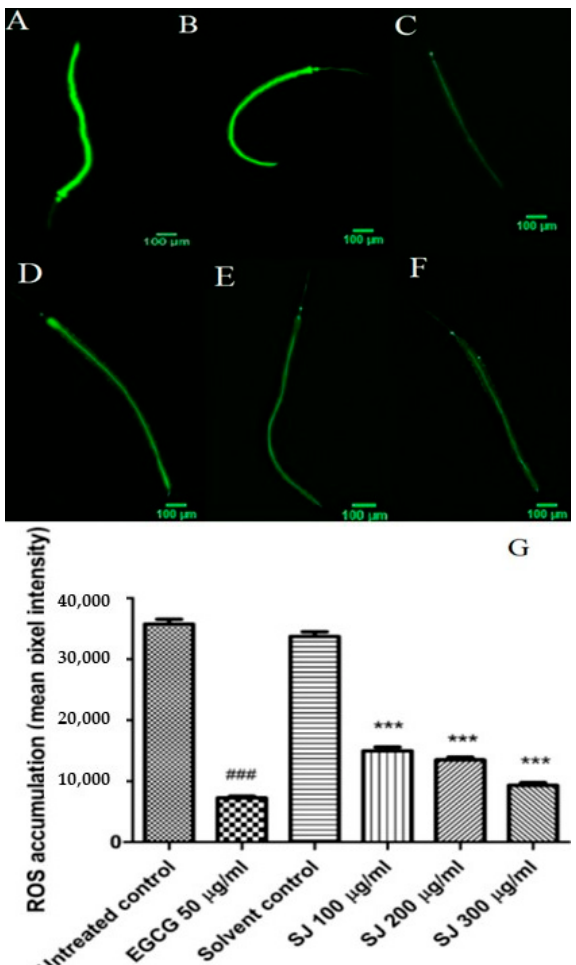
Figure 3. Intracellular reactive oxygen species (ROS) levels in C. elegans . ( A – F ) Pictures demonstrate intracellular ROS levels in worms: ( A ) untreated control, ( B ) solvent control, ( C ) ( − )-epigallocatechingallate (EGCG) 50 µ g / mL, ( D ) SJ 100 µ g / mL, ( E ) SJ 200 µ g / mL, ( F ) SJ 300 µ g / mL, and ( G ) quantification of ROS levels using fluorescence intensity for di ff erent treated groups. SJ treatment resulted into lower ROS levels. Data represents the mean of three assays. Analysis was made through one-way ANOVA followed by Bonferroni’s method. *** p < 0.001 in comparison with solvent control and ### p < 0.001 in comparison with untreated control.